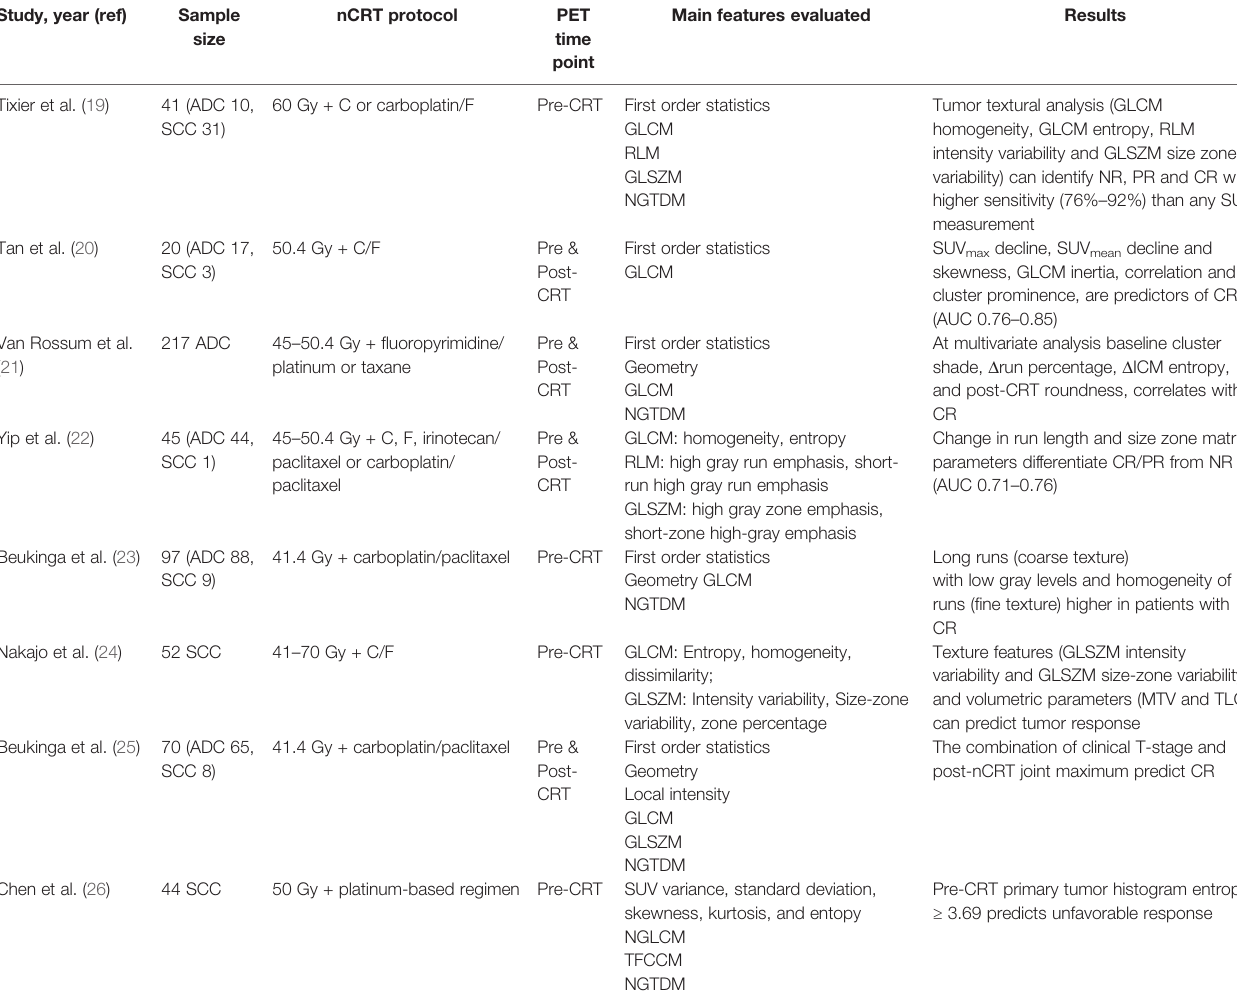
TABLE 3 | Recent fi ndings on the application of PET radiomics for the prediction of response in esophageal cancer patients treated with neoadjuvant chemo- radiotherapy (summary). Study, year